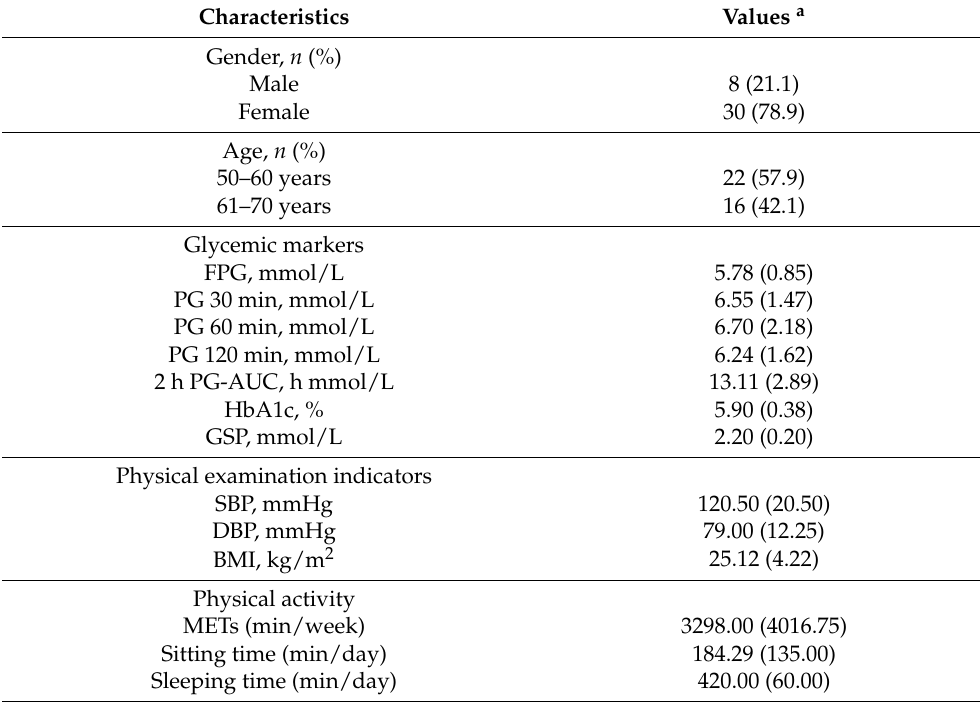
Table 3. Baseline characteristics of the